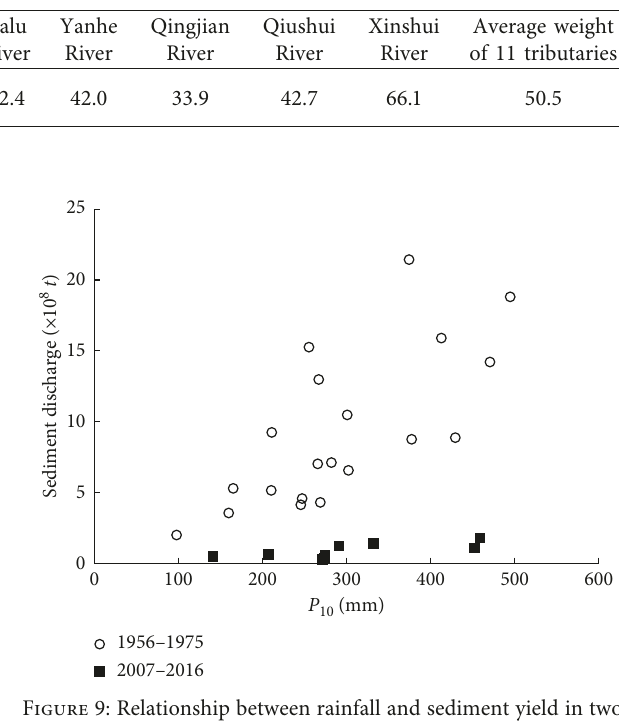
Table 5: The proportion of sediment yield produced by P